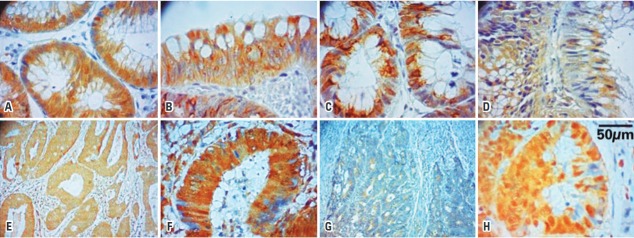
Photomicrographs of the immunohistochemical staining of the proteins represented by the brownish color in the cytoplasm of cells. Beta-catenin (A – colonic adenoma, 200X; B – colorectal carcinoma, 200X); adenomatous polyposis coli (C – colonic adenoma, 200X; D – colorectal carcinoma, 200X); GSK3β (E – colonic adenoma, 100X; F – colorectal carcinoma, 200X); axin 1 (G – colorectal carcinoma, 100X); ubiquitin (H – colorectal carcinoma, 200X)